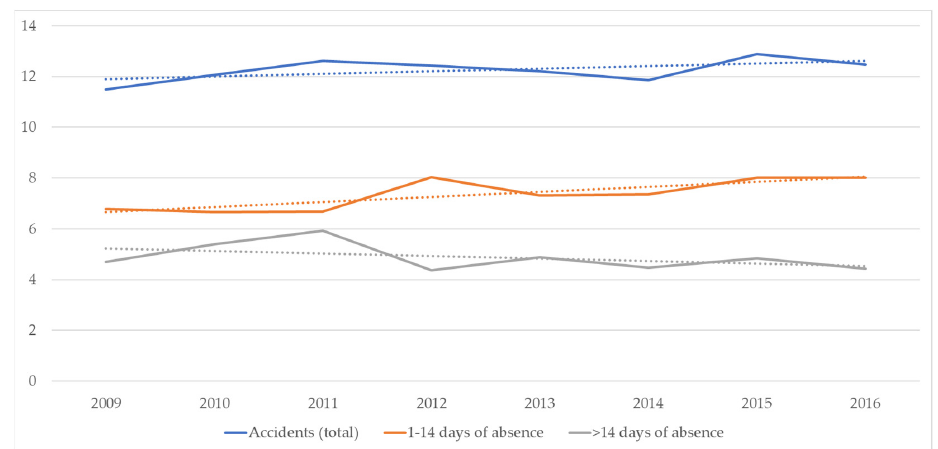
Figure 3. Number of employees in the six smallest subtrades, 2009–2016. Based on data from [27].